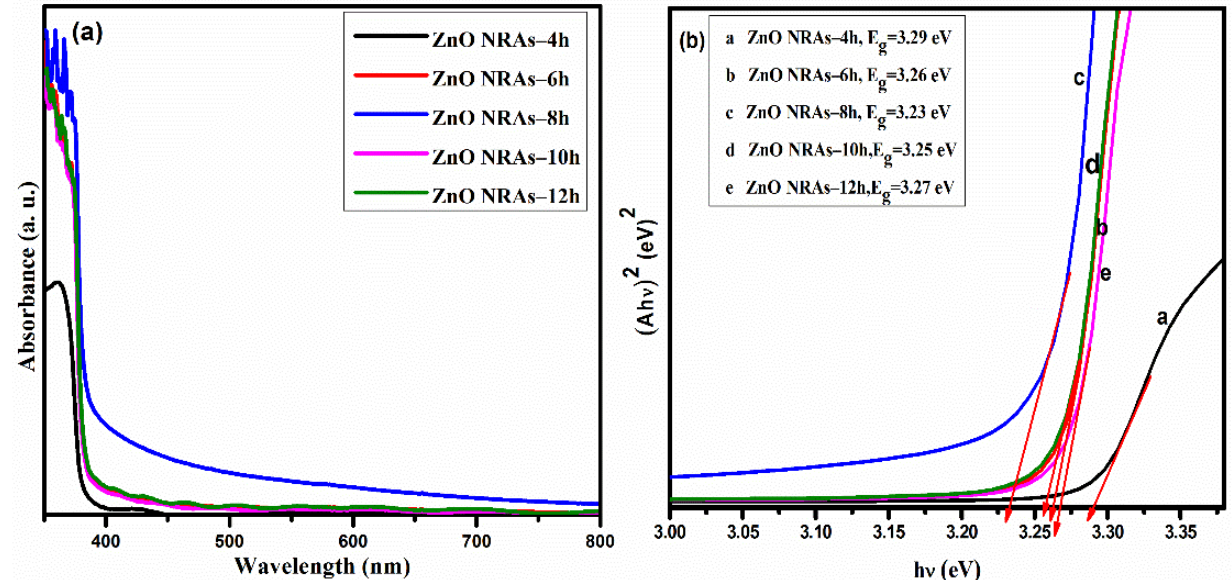
Figure 8. ( a ) The absorbance spectra and ( b ) Tauc plot (α hv ) 2 vs. energy ( hv ) of ZNRAs prepared at various hydrothermal growth times.